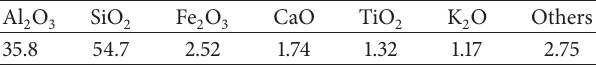
Table 1: The chemical composition of CFA